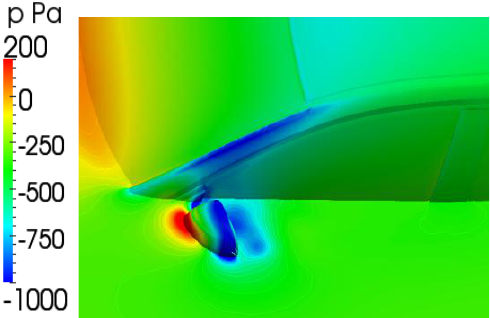
Figure 14. Pressure contour obtained using the SLM method at t = 0.765 s.